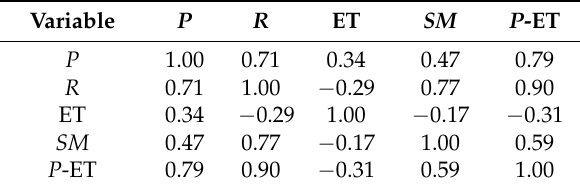
Figure 7. Time series smoothed using 13-month moving average filter: ( a ) ET and temperature (TEM), ( b ) ET and relative humidity (RHU), ( c ) ET and wind speed (WIN) and ( d ) ET and soil moisture (SM). Table 5. Correlation coefficient between each hydrological component, based on the time series smoothed using the 13-month moving average filter, as in Figure 7. Variable P R ET SM P